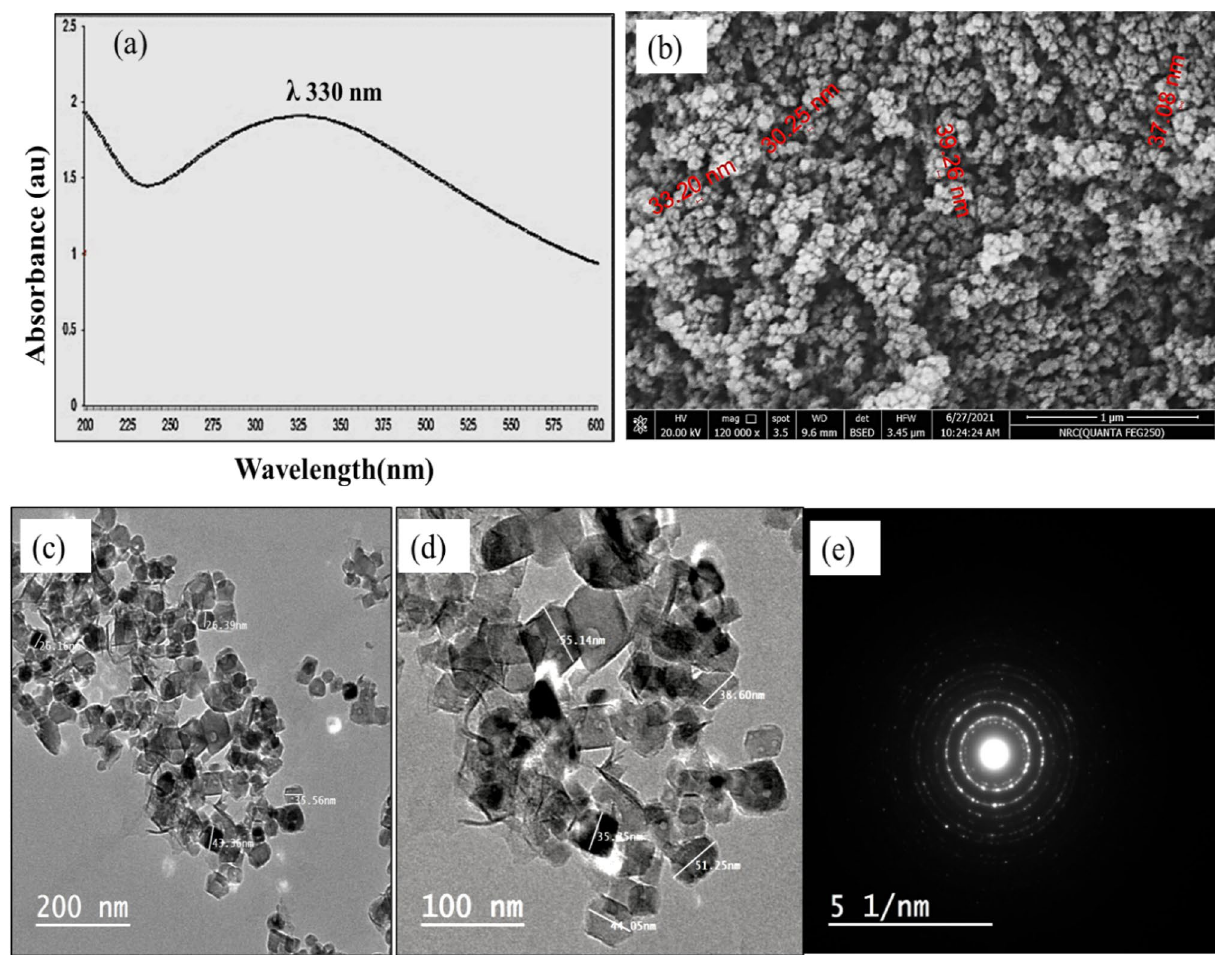
Figure 1. (a) UV–Visible absorption spectrum of RcNps. (b) FESEM micrograph of RcNps (c) HR-TEM micrograph of RcNps at 200 nm, (d) HR-TEM micrograph of RcNps at 100 nm, and (e) selected area for electron diffraction patterns showing the crystallinity of